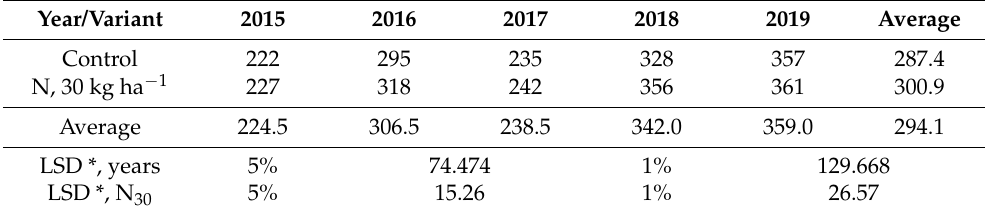
Table 4. Stalk height in the panicle stage (cm) during